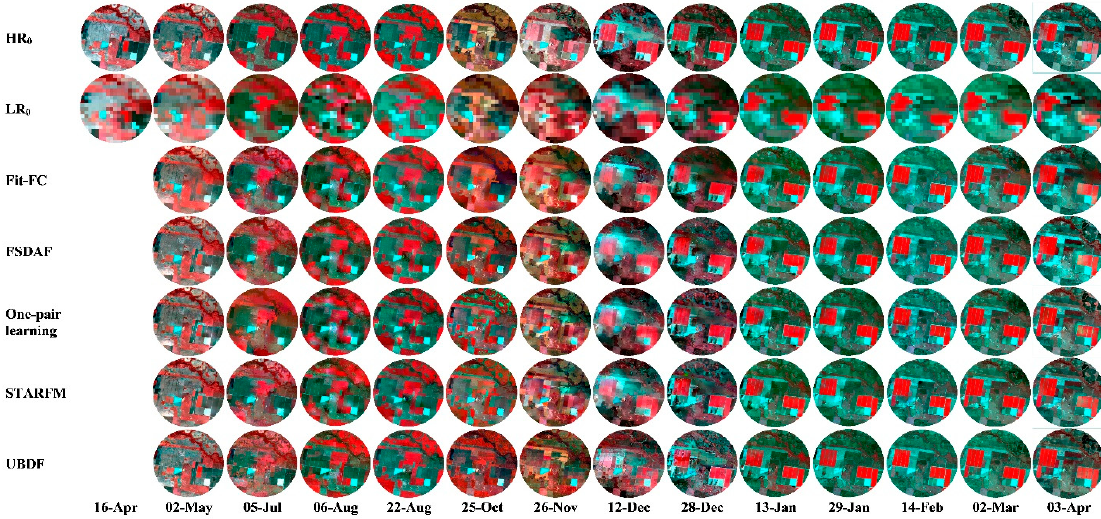
Figure A3. Observed Landsat data and simulated Landsat-like images with the fusion method indicated above for the subregion C of Gwydir in Figure 2. All images are displayed in chronological order from 2004 to 2005 (NIR, red and green as RGB).